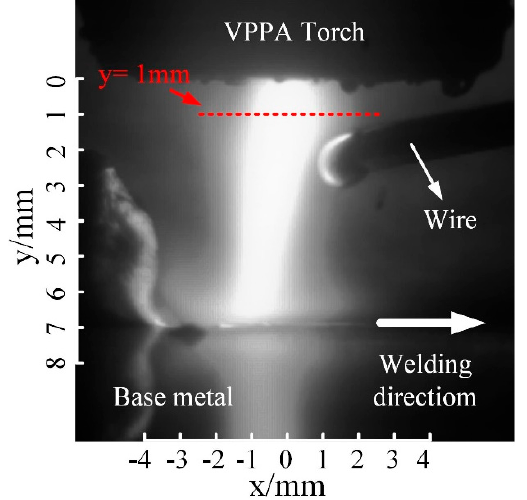
Figure 4. The grayscale image at 0.5 ms.